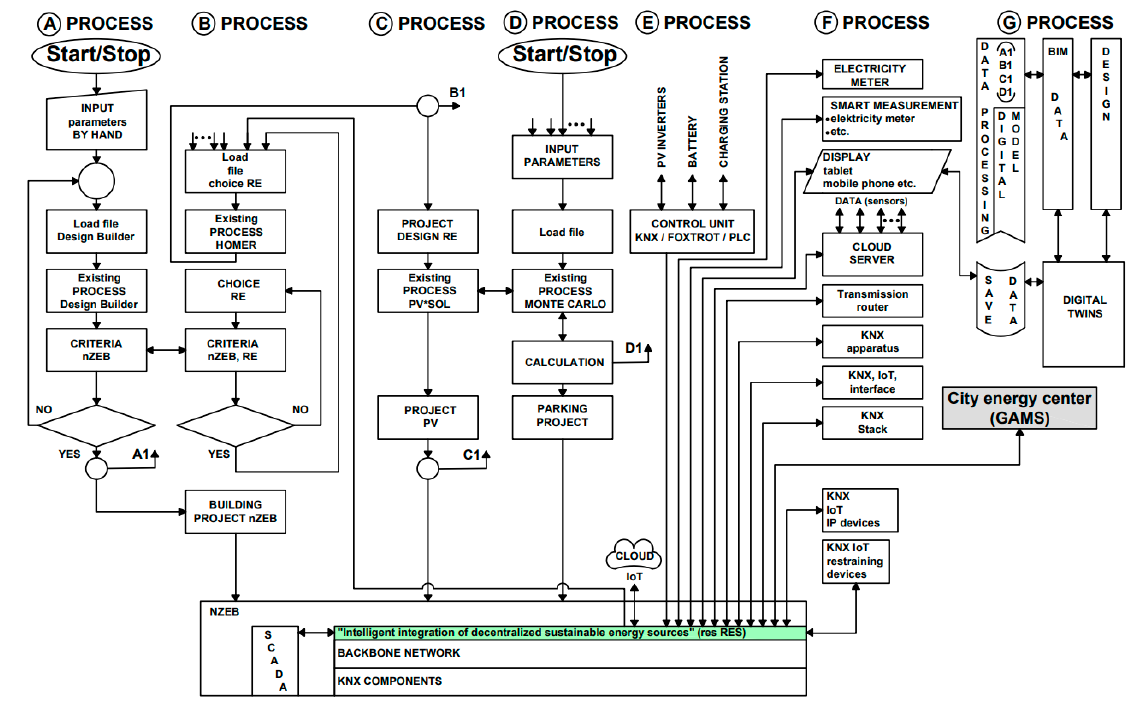
Figure 4. NZEB energy model with the application of automated systems of technical equipment of buildings.